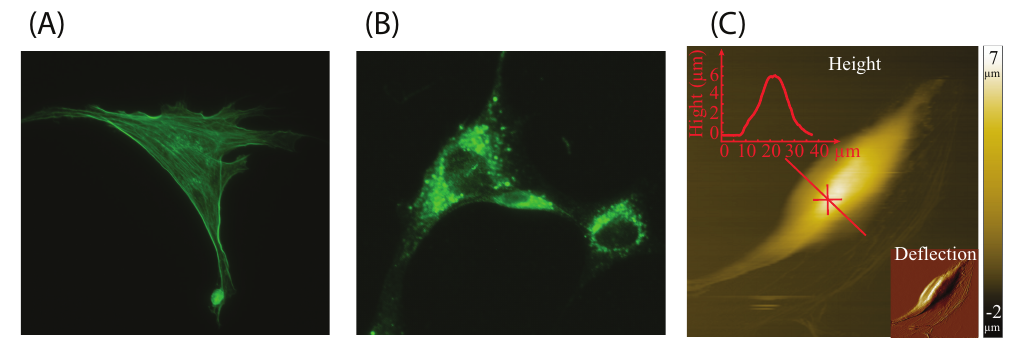
Figure 1. The fluorescent images of ( A ) F-actin and ( B ) microtubules in control NIH/3T3 cells, respectively. ( C ) AFM topography image of a NIH/3T3 cell, where the red cross denotes the poroelasticity